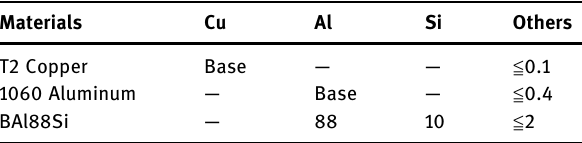
Table 1: Chemical composition of matrix